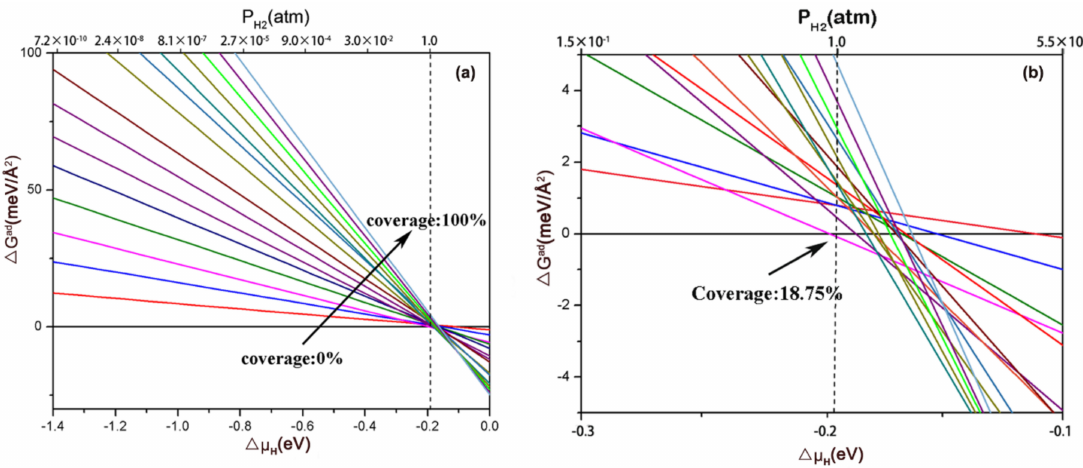
Figure 6. ∆ G ad at 298K with pressure and ∆ µ H ranging from: ( a ) ∆ µ H − 1.4 to 0 eV and ( b ) − 0.3 to − 0.1 eV. Note that the dot line is used to clearly reflect the values of ∆ G ad ( T , p ) at 1 atm H The intersection points show the values of ∆ G ad ( T , p ) for di ff erent coverages at 1 atm H 2 and